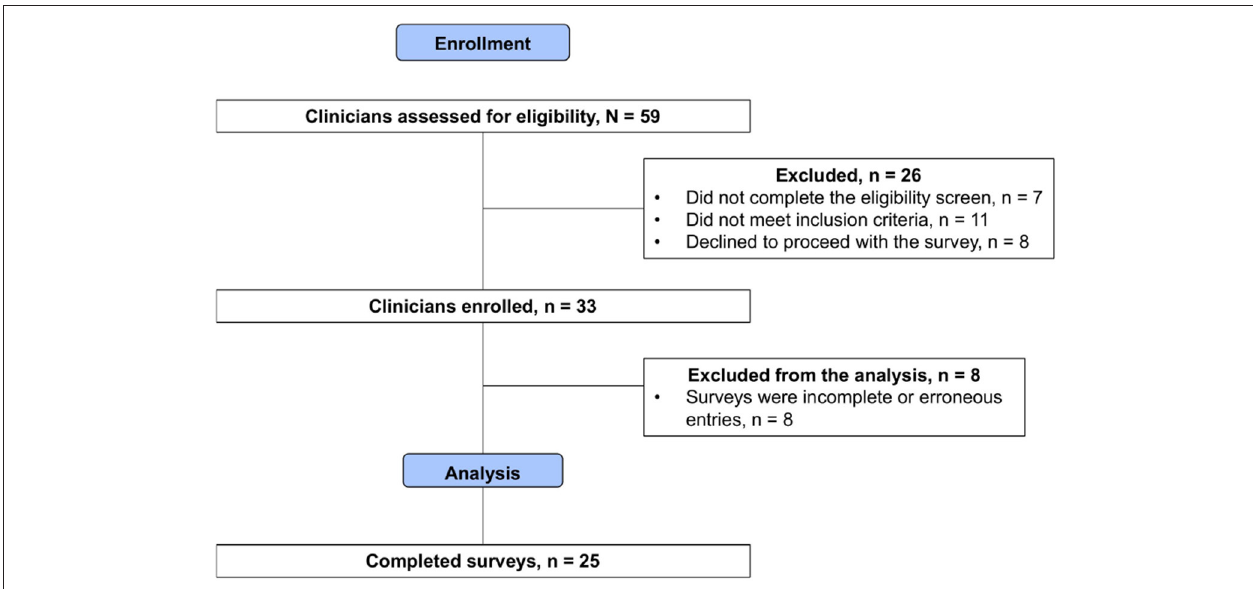
FIGURE 6 | Consort flow diagram of clinician enrollment. After removing ineligible samples, 25 surveys were included for comparative analysis.